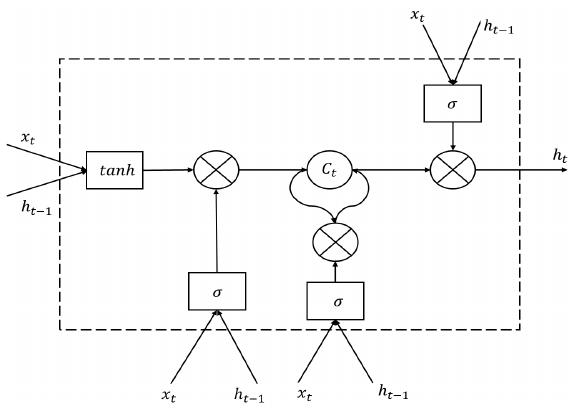
Figure 2. Long Short-Term Memory (LSTM)